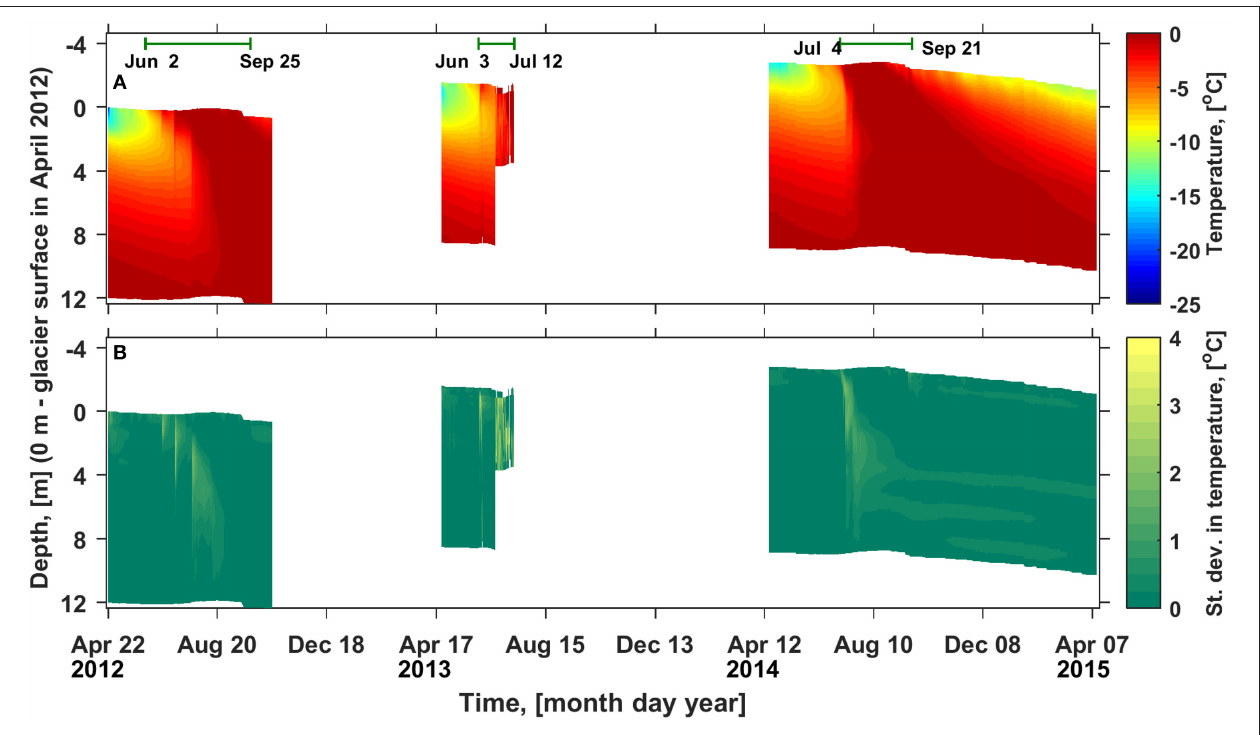
FIGURE 8 | Evolution of the snow and firn temperature measured at the Lomonosovfonna ice field in April 2012–2015. The depth scale was corrected using the model output to account for the accumulation/melt at the surface and gravitational settling below it. (A) Temperature values interpolated to a finer mesh (0.1 m between grid nodes) and averaged over all thermistor strings installed in each of the field campaigns. Green bars in the upper part of the panes mark the time intervals used in calculations presented in Figures 9 , 11 . (B) Evolution of the standard deviation in snow and firn temperature at one depth used here as a measure of the horizontal temperature